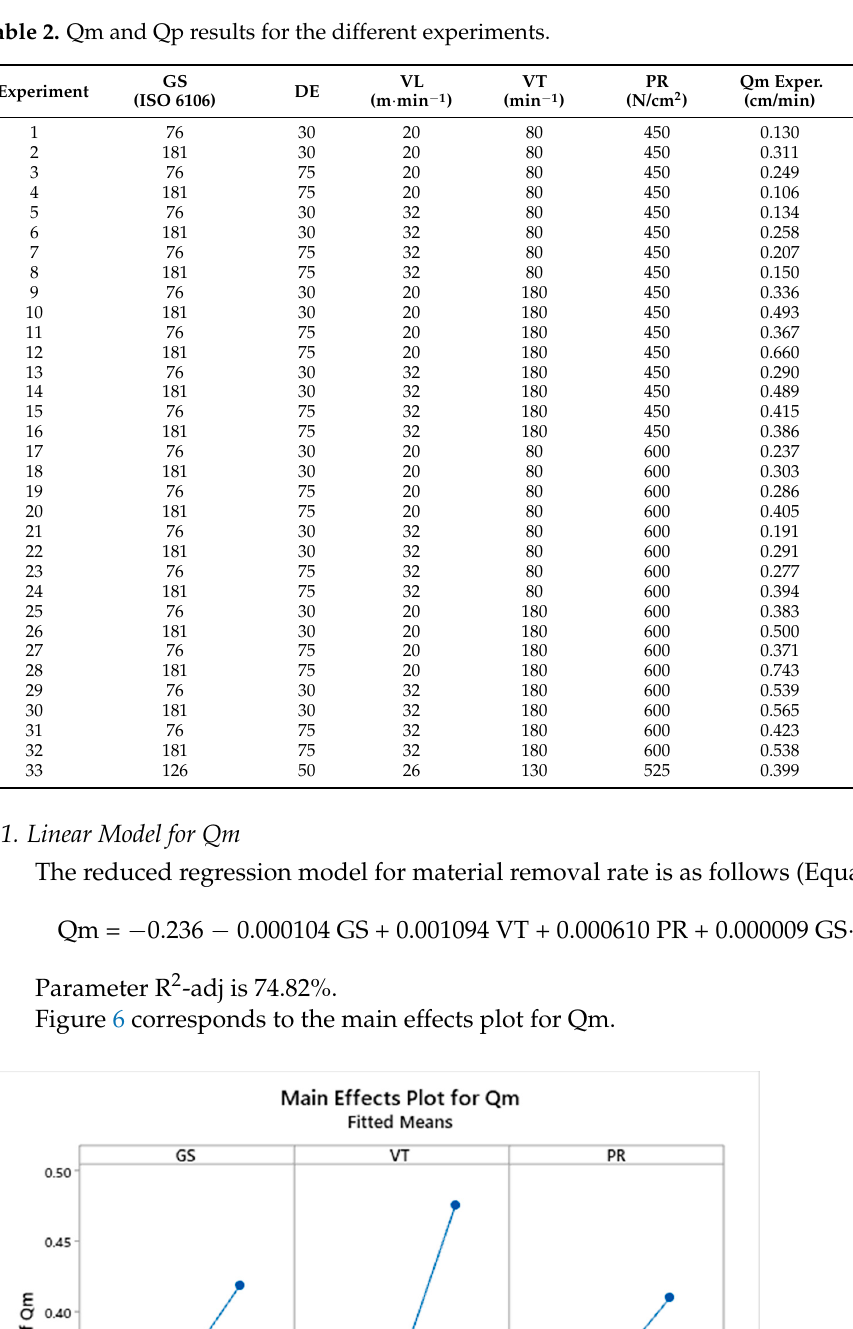
Table 2. Qm and Qp results for the different experiments.